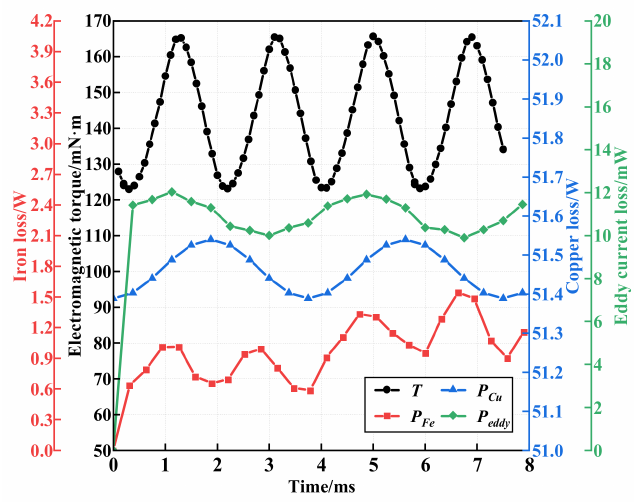
Figure 4. The electromagnetic torque and motor